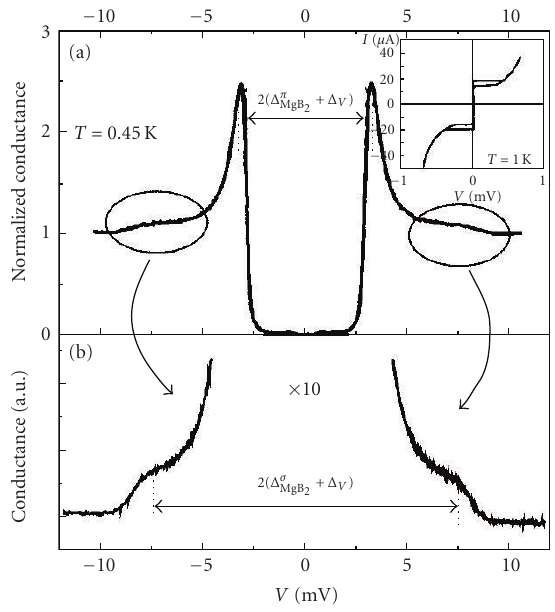
Figure 6: (From [26]) Tunneling characteristics of a MgB 2 /Al 2 O 3 /V tunnel junction at 0.45 K, showing σ -gap tunneling features. Inset: Josephson pair tunneling occurs with a thinner barrier. c Institute of Physics.